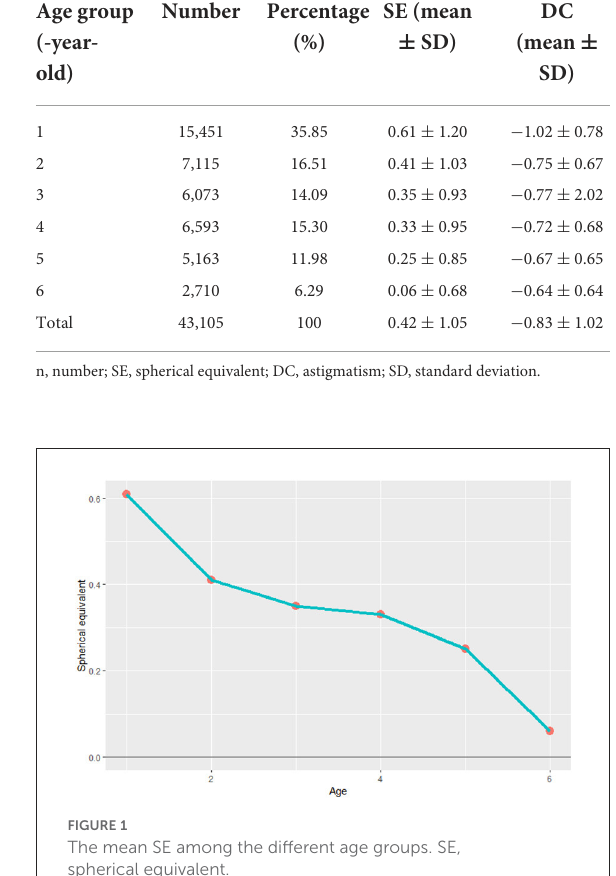
TABLE 1 Refractive error of the 1-6 years old children in the Changsha Children Eye Study.